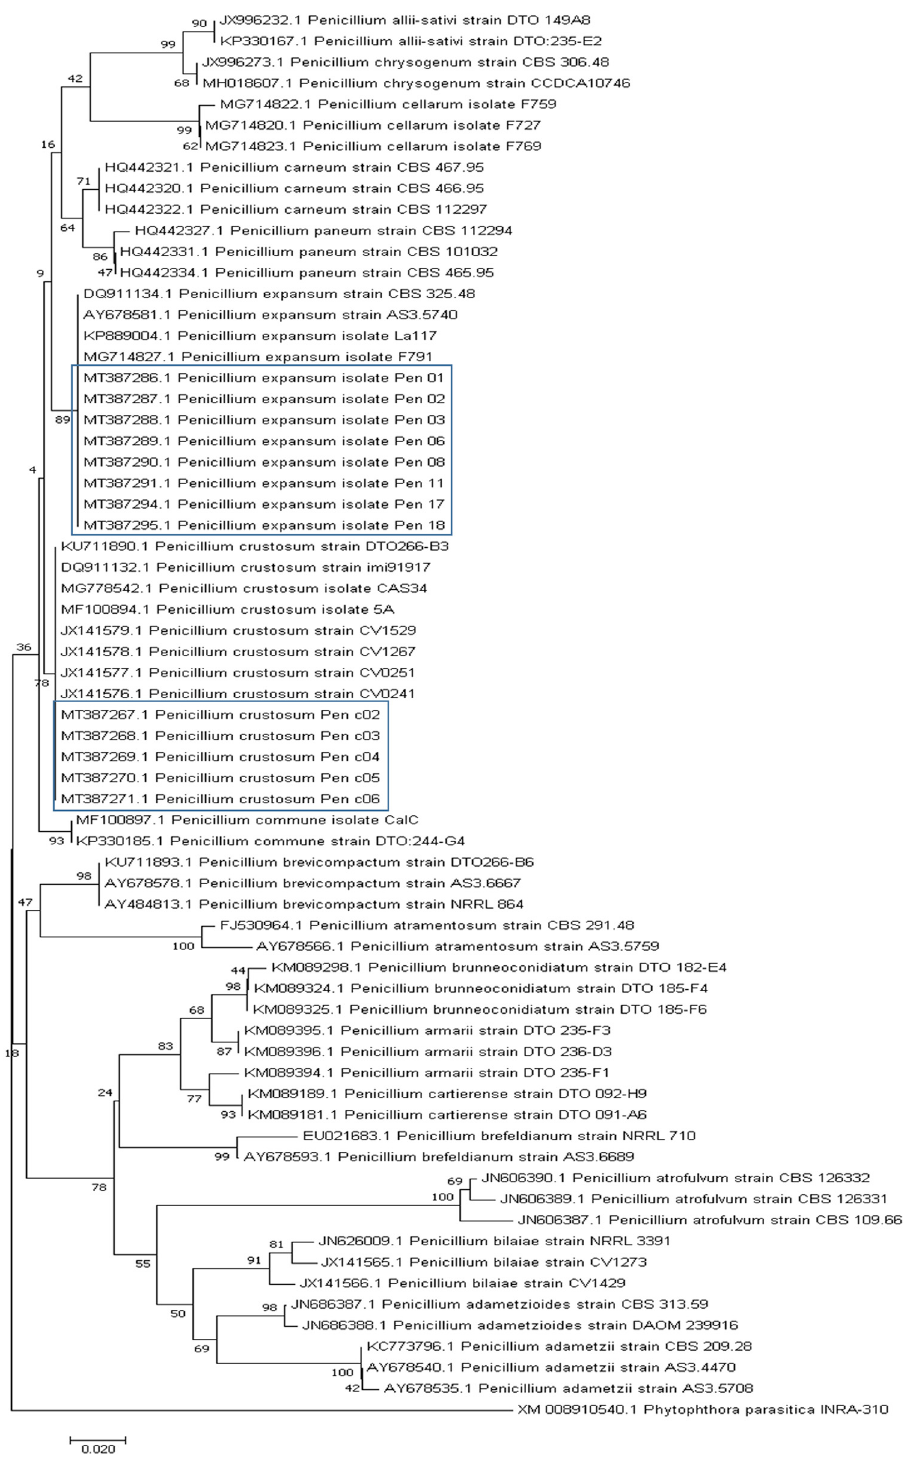
Figure 5: Phylogenetic tree based upon MUSCLE alignment of the calmodulin region nucleotide sequences of Penicillium isolates causing fruit rots of grapes. The evolutionary history was inferred using the neighbour - joining method. The optimal tree with the sum of branch length = 0.99983118 is shown. The percentage of replicate trees in which the associated taxa clustered together in the bootstrap test ( 1,000 replicates ) is shown next to the branches. The tree is drawn to scale, with branch lengths in the same units as those of the evolutionary distances used to infer the phylogenetic tree. The evolutionary distances were computed using the Maximum Composite Likelihood method and are in the units of the number of base substitutions per site. The analysis involved 67 nucleotide sequences. All positions containing gaps and missing data were eliminated. There were a total of 181 positions in the fi nal dataset. Evolutionary analyses were conducted in MEGA7. The tree is rooted with Phytophthora parasitica isolate ( XM_008910540.1 )